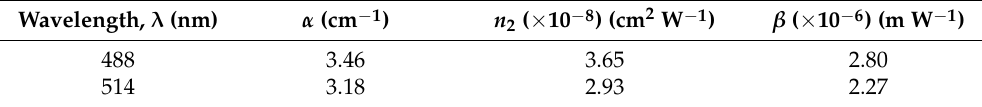
The z-scan result of the silver nanoparticles for the open aperture case (normalized transmission) measured at a wavelength of 514 nm is shown in Figure